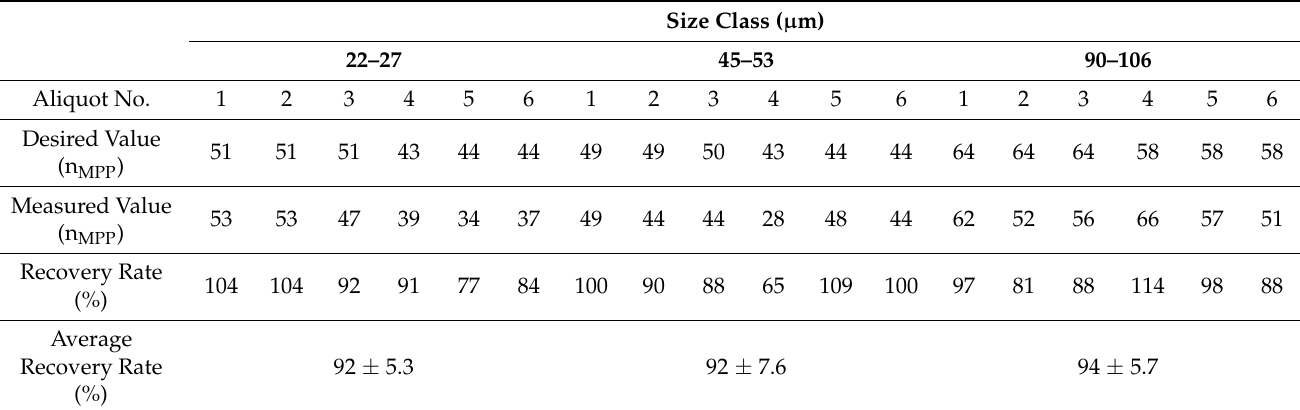
Table 4. Validation of sample splitting procedure with different size